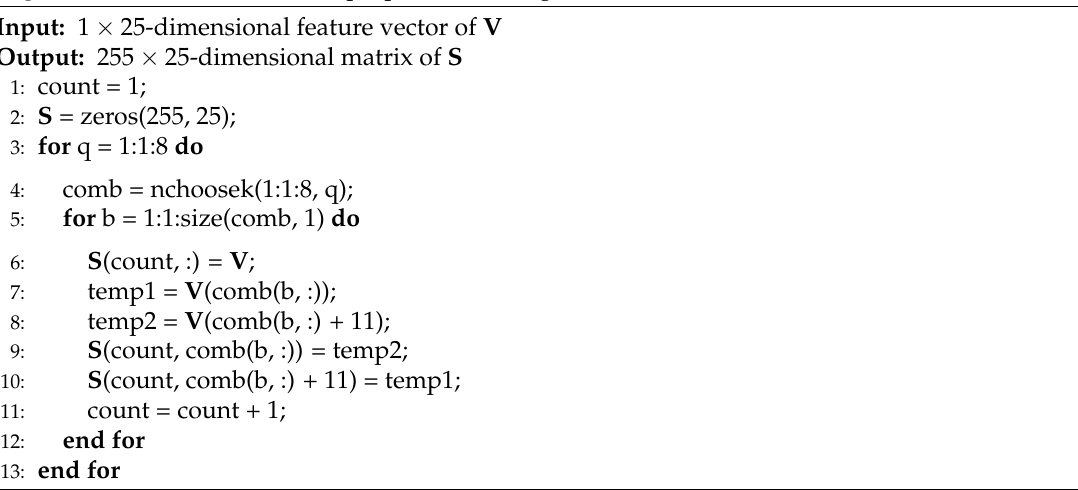
Algorithm 1 Pseudocode of the proposed data augmentation